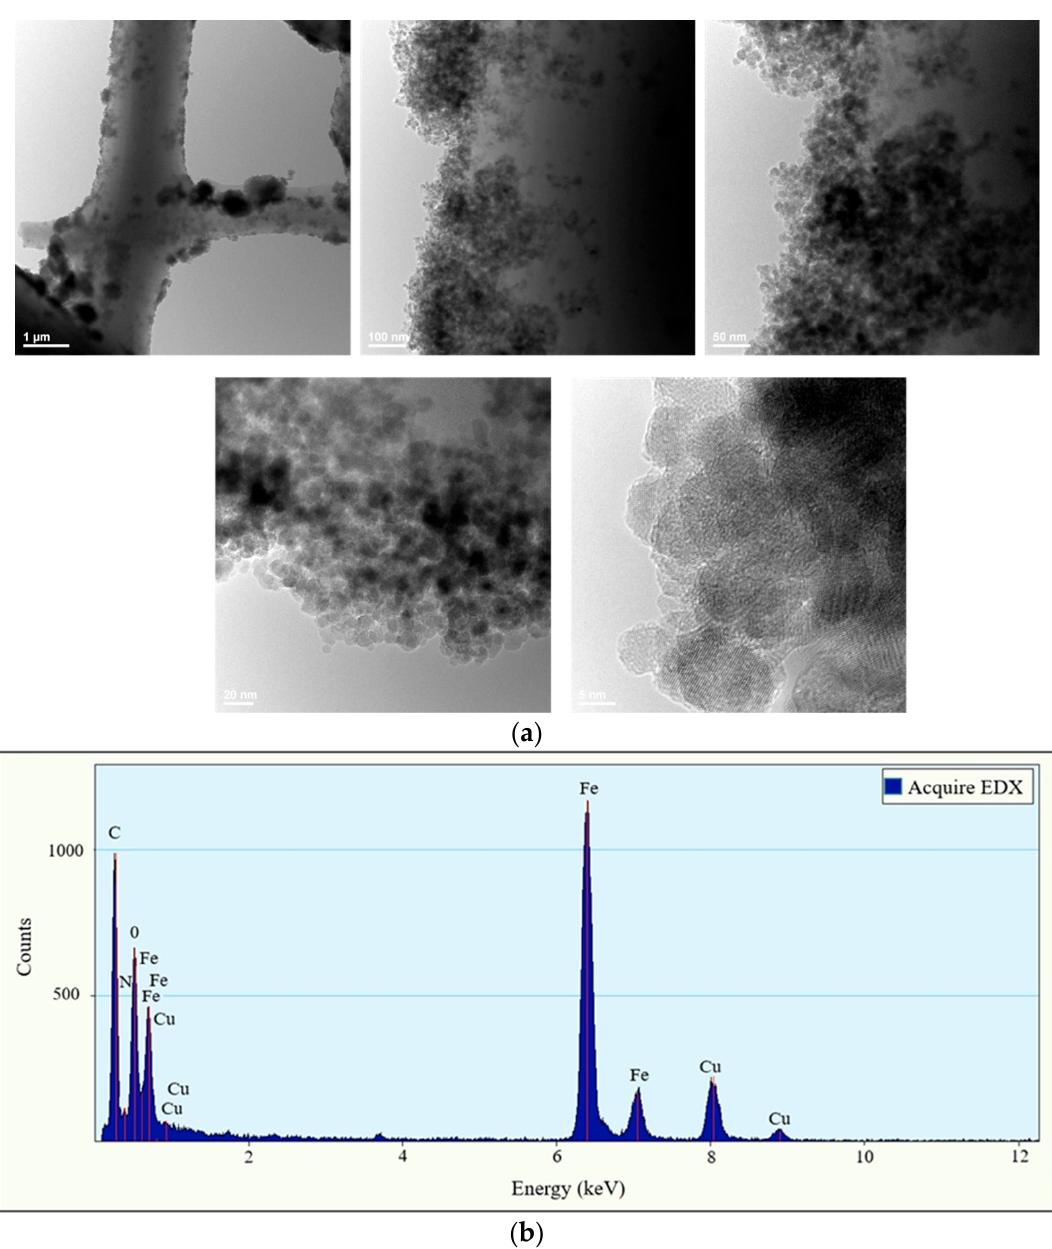
Figure 7. TEM bright ‐ field images ( a ) and EDX spectrum of the magnetically functionalized electrospun membranes ( b ).